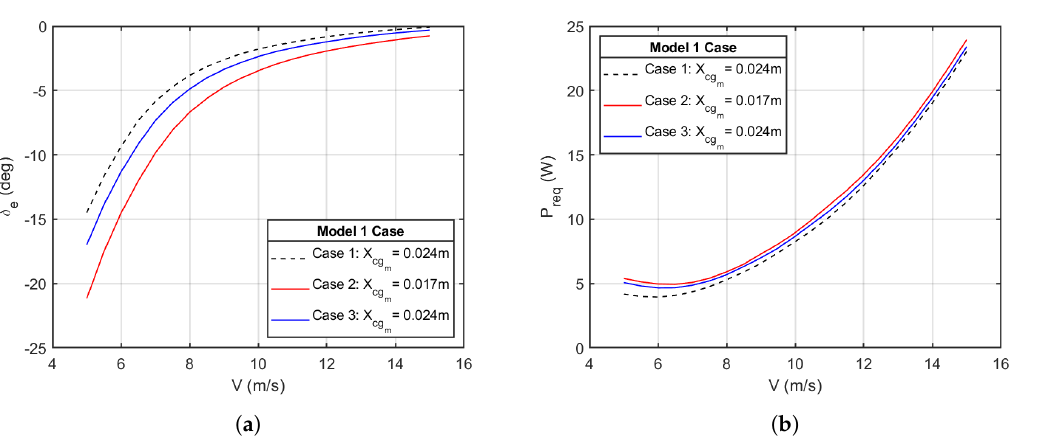
Figure 8. Model 1 trim in steady level powered flight for a range of airspeed. ( a ) Elevator deflection. ( b ) Power required. Table 6. Trimmed steady cruise elevator deflection and power required for Model 1